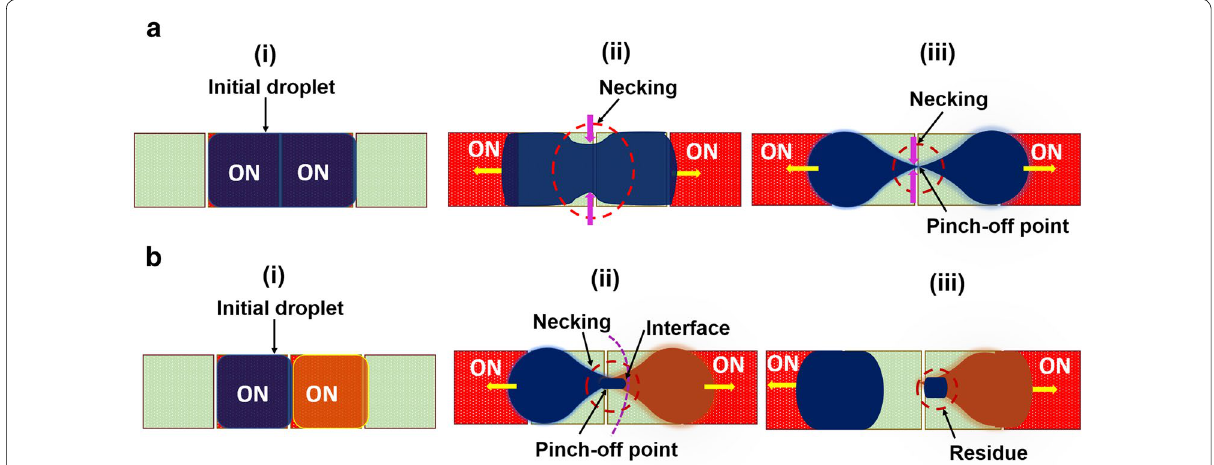
Fig. 1 Steps during splitting of: a a single-phase droplet, and b a multiphase droplet for phase separation. Illustrations are top